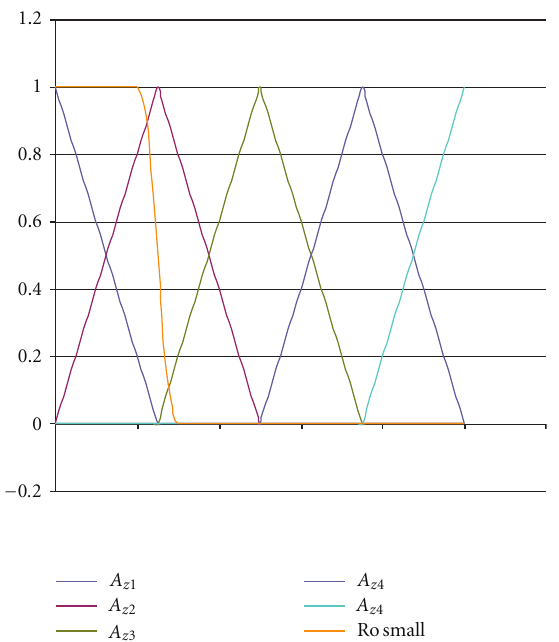
Figure 9: Inclusion areas for the fuzzy association rule R 2.